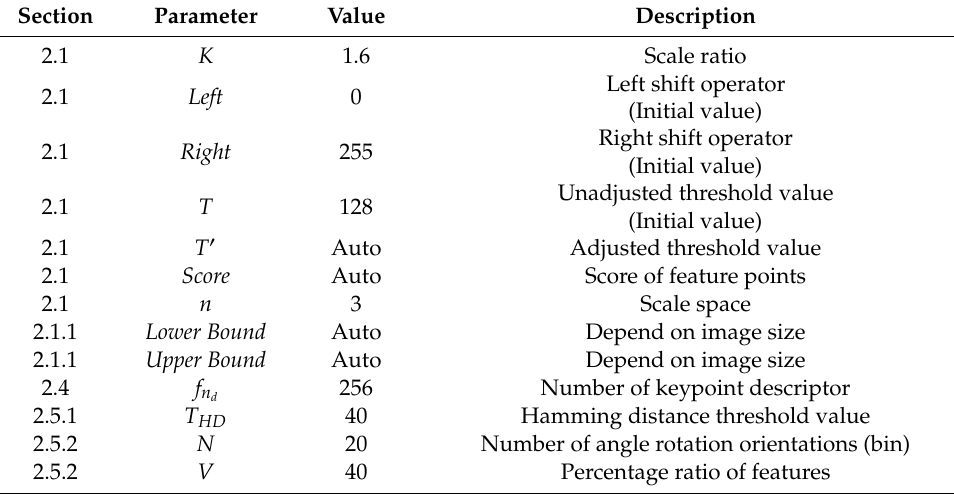
Table 5. Parameters of the Fast Binary Robust Local Feature (FBRLF) algorithm.